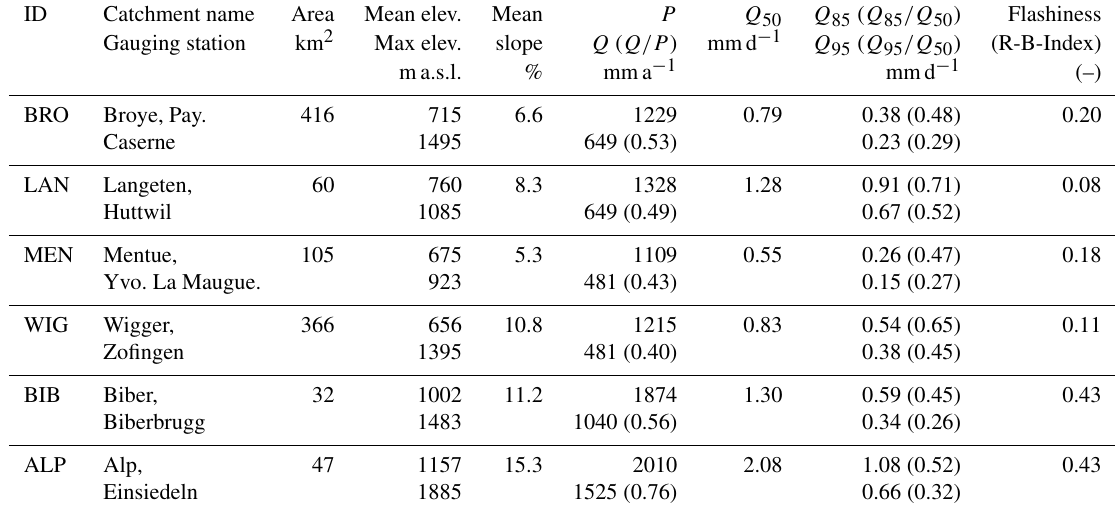
Table 1. Catchments characteristics, climate and streamflow metrics. Metrics are based on observed precipitation ( P ) and simulated stream- flow ( Q , Q 50 , Q 85 , Q 95 ) time series from 1976 to 2015. Ratios in brackets are related to P and Q 50 , respectively. Flashiness is a metric to quantify and compare the path length of the hydrograph (Baker et al., 2004), the higher the value, the flashier the